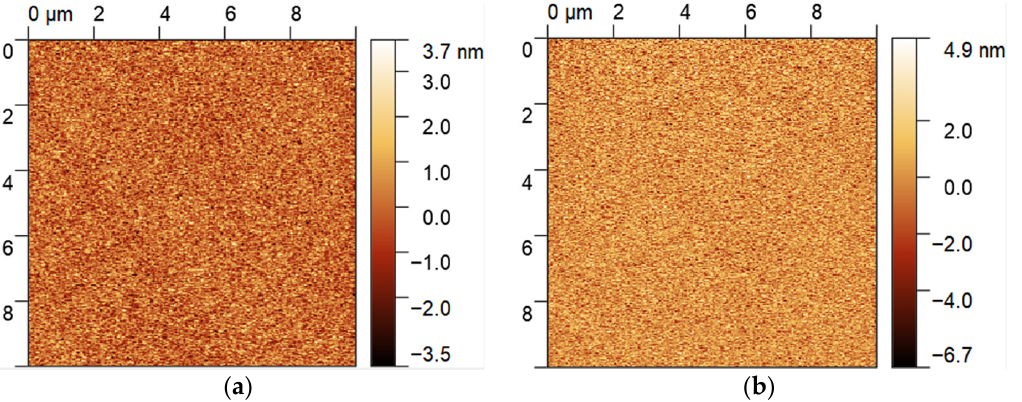
Figure 3. AFM images of AlN films with thicknesses of ( a ) 0.8 µm and ( b ) 1.2 µm in a range of 10 × 10 µm.